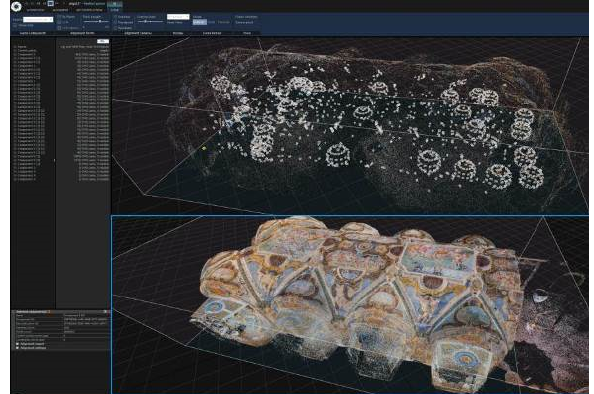
Figure 18. Representation of the images positions (up) and obtained pointcloud (down) This combination has managed to significantly increase the geometrical and textural accuracy and detail. Comparison of a model obtained only from TLS data with the model of data supplemented by photogrammetric images are shown in Figure 19.